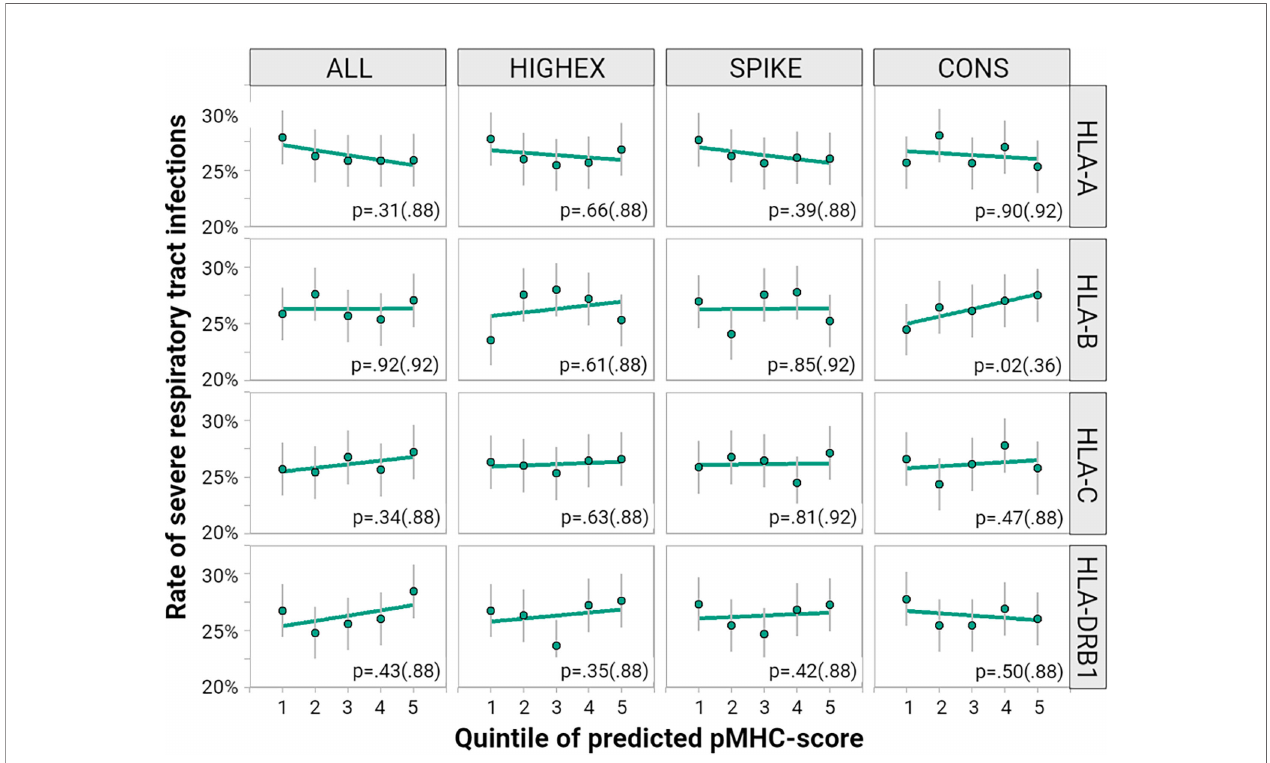
FIGURE 6 | Impact of different peptide-MHC scores on the course of COVID-19. We correlated quintiles of predicted pMHC-scores calculated for HLA-A, -B, -C and -DRB1 for each of the peptide pools: the entire peptidome (ALL), highly expressed proteins (HIGHEX), the spike glycoprotein (SPIKE) and conserved regions (CONS). The fi gure displays the rate of severe respiratory tract symptoms (green dots) for each quintile along with 95% con fi dence intervals (gray lines). The green regression line represents a linear approximation of the rate of individuals with severe respiratory symptoms across the quintiles. The p values come from tests for a linear relationship based on multivariable logistic regression models with p values adjusted for multiple testing provided in